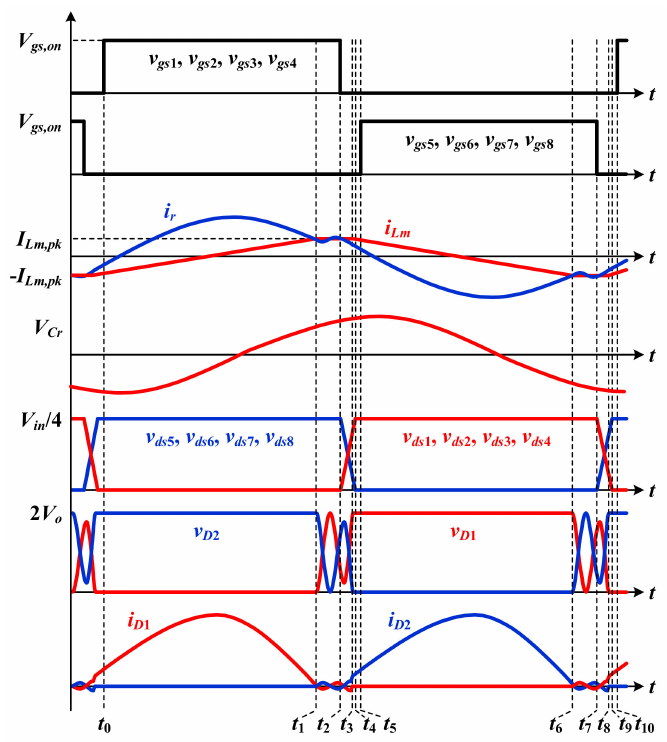
Figure 3. Operational waveforms of the LLC resonant converter.